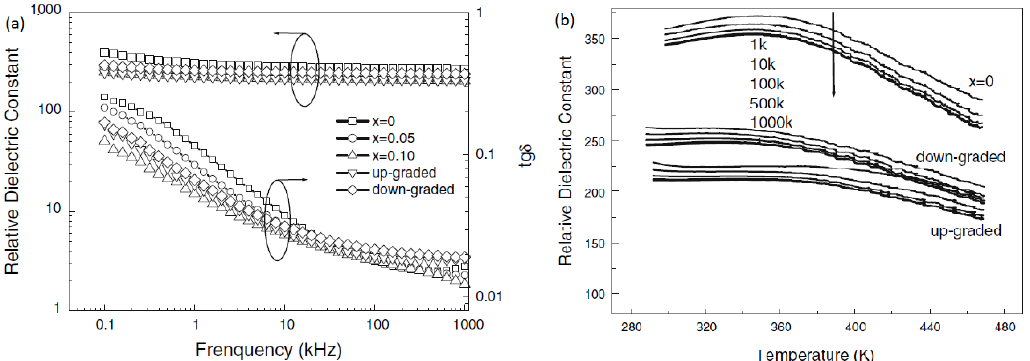
Figure 11. The dielectric constant and dielectric loss of the homogenous and compositionally graded BCZT thin films as functions of frequency, measured at room temperature ( a ). The dielectric constant of Ba 1 − x Ca x Zr 0.05 Ti 0.95 O 3 (x = 0) and compositionally graded BCZT thin films as a function of temperature ( b ). Reprinted with permission from [87]. Copyright 2008 Springer Nature.